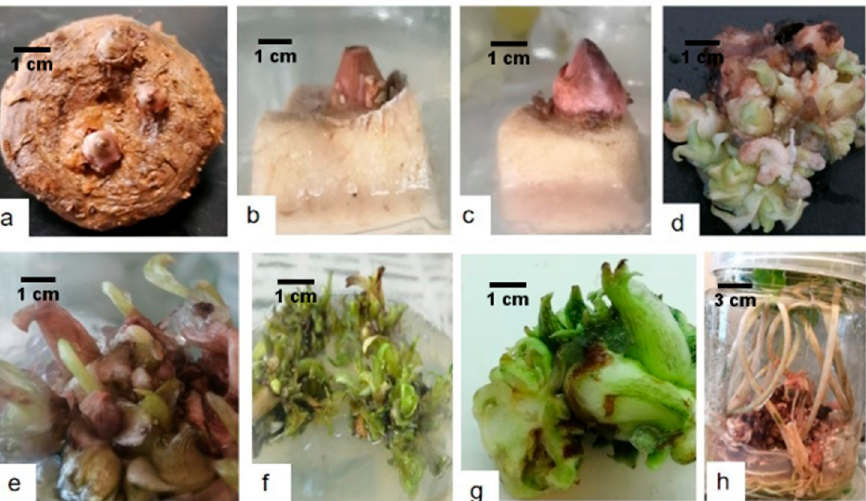
Figure 2. The procedure for konjac aseptic seedlings induction. ( a ) Two-year-old konjac tuber. ( b ) Corm with apical bud. ( c ) Corm with apical bud inoculated after 14 days. ( d ) Buds differentiated after 35 days of culture. ( e ) The different buds that grew (after 45 days). ( f ) Seedling formation and development ( g ). Seedling regenerated ( f ). Tiny seedlings zoomed in, cut, and transferred to a new medium. ( h ) Seedling growth and development after 60 days of sub-culture.